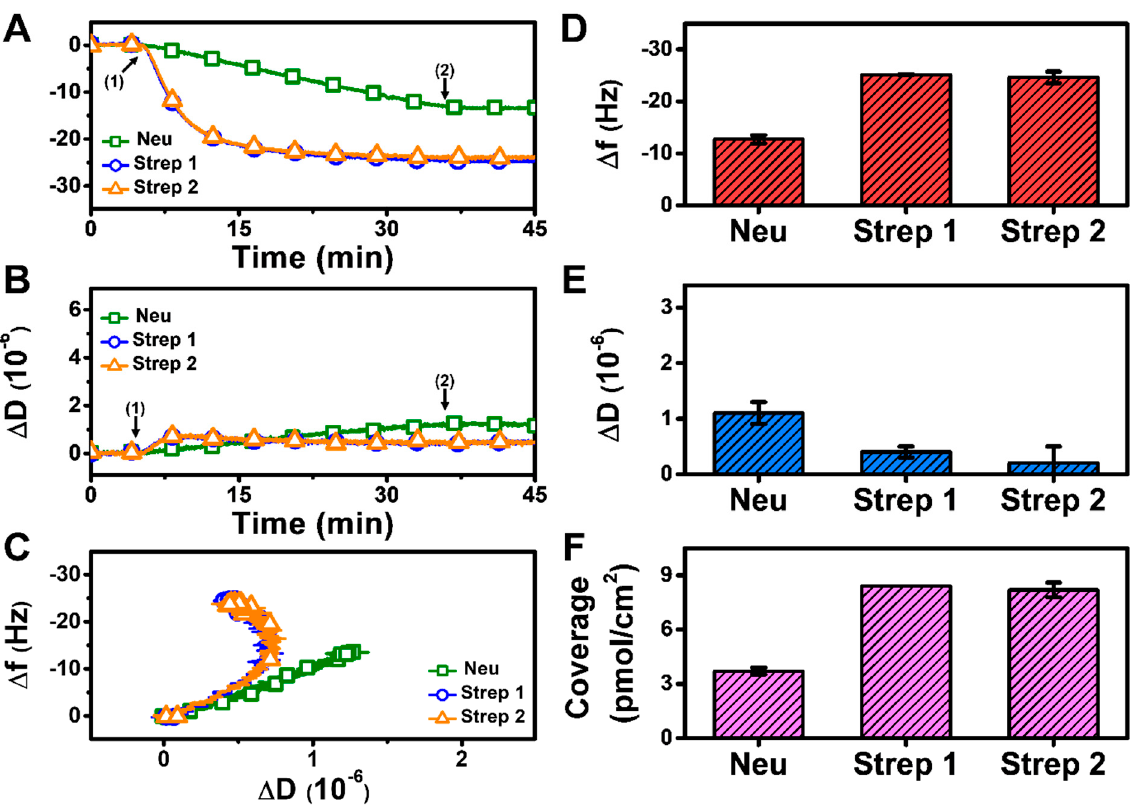
Figure 3. QCM-D measurement responses for Neu and Strep attachment to biotinylated SLB platform at pH 7.5. Time-resolved QCM-D ( A ) frequency ( Δ f) and ( B ) energy dissipation ( Δ D) for protein addition. The initial baselines correspond to the shifts for a biotinylated SLB and protein was added starting at t = 5 min (arrow 1), followed by buffer washing from t = 35 min (arrow 2). ( C ) Time-independent curves of Δ f vs. Δ D shifts corresponding to data in panels ( A , B ). Final ( D ) Δ f and ( E ) Δ D shift values along with ( F ) maximum surface coverage of adsorbed protein molecules on the biotinylated SLB surface are reported as mean ± standard deviation from n = 3 experiments.